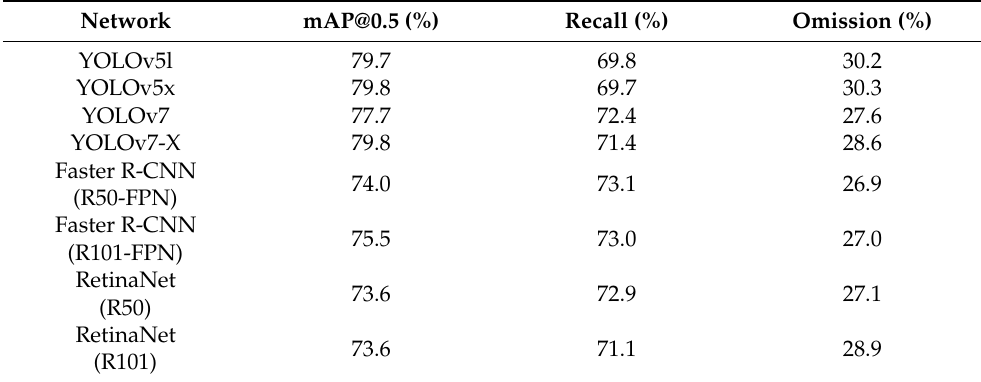
Table 4. The training results based on dataset-2 (division by dates).